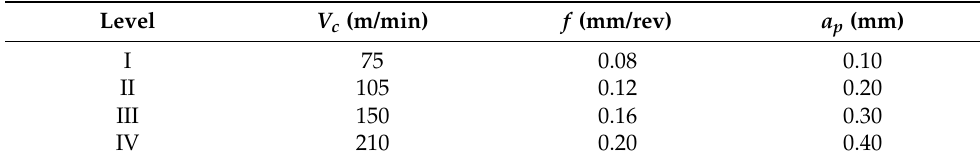
Table 1. Process inputs and levels of the finite element (FE) model.